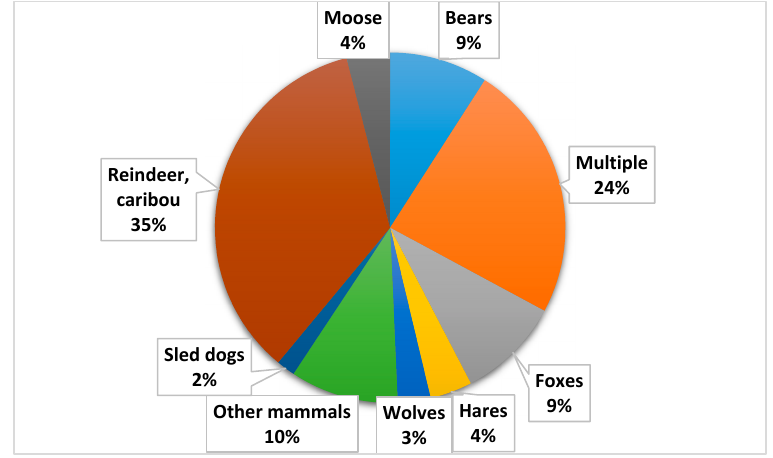
Figure 4. Percentage proportion of mammal species in the evaluated articles about the health status of Arctic mammals from 2009 to 2018 (n = 231).